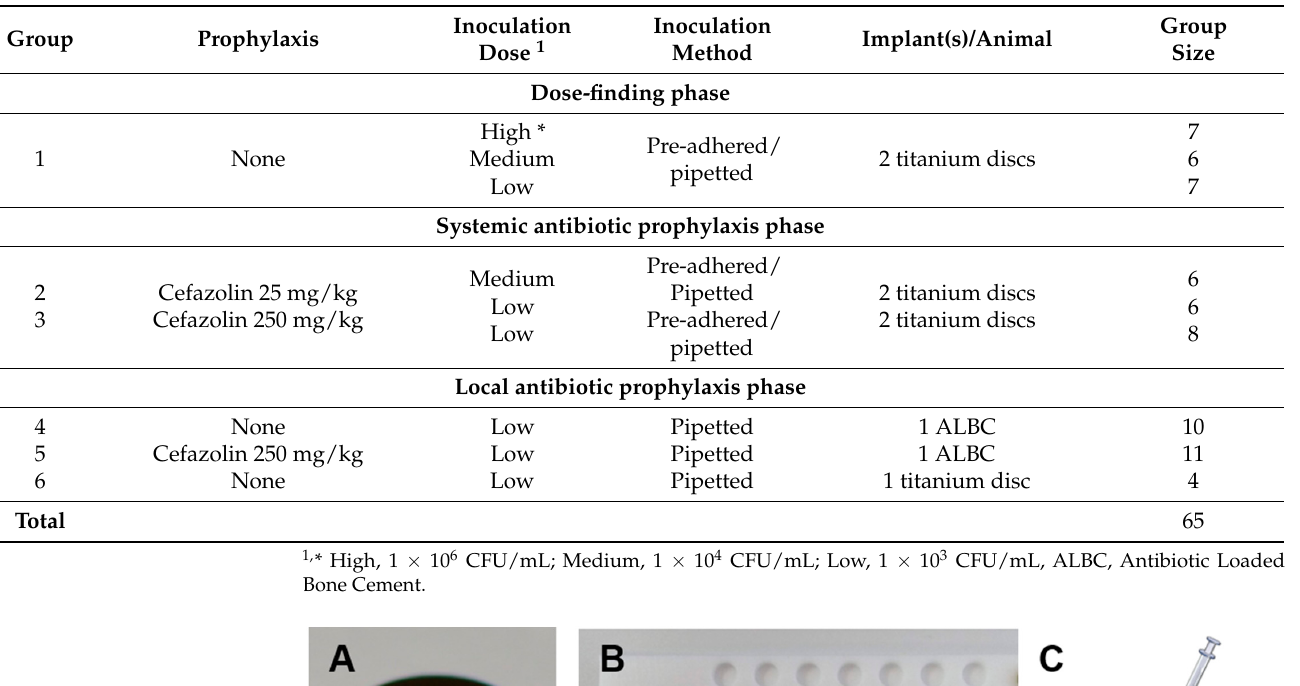
Table 1. Overview of study design.